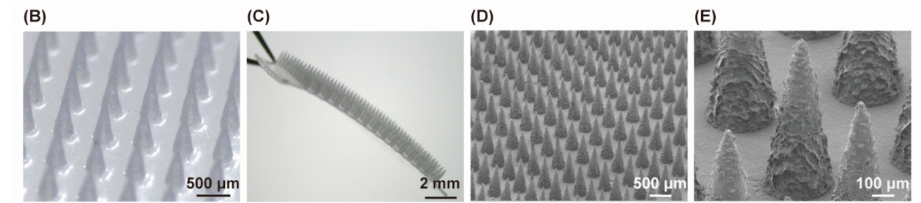
Figure 2. ( A ) Nuclear magnetic resonance ( 1 H-NMR) spectrum of HA and mHA; the microscope images ( B , C ) and scanning electron microscopy (SEM) images ( D , E ) of MN.